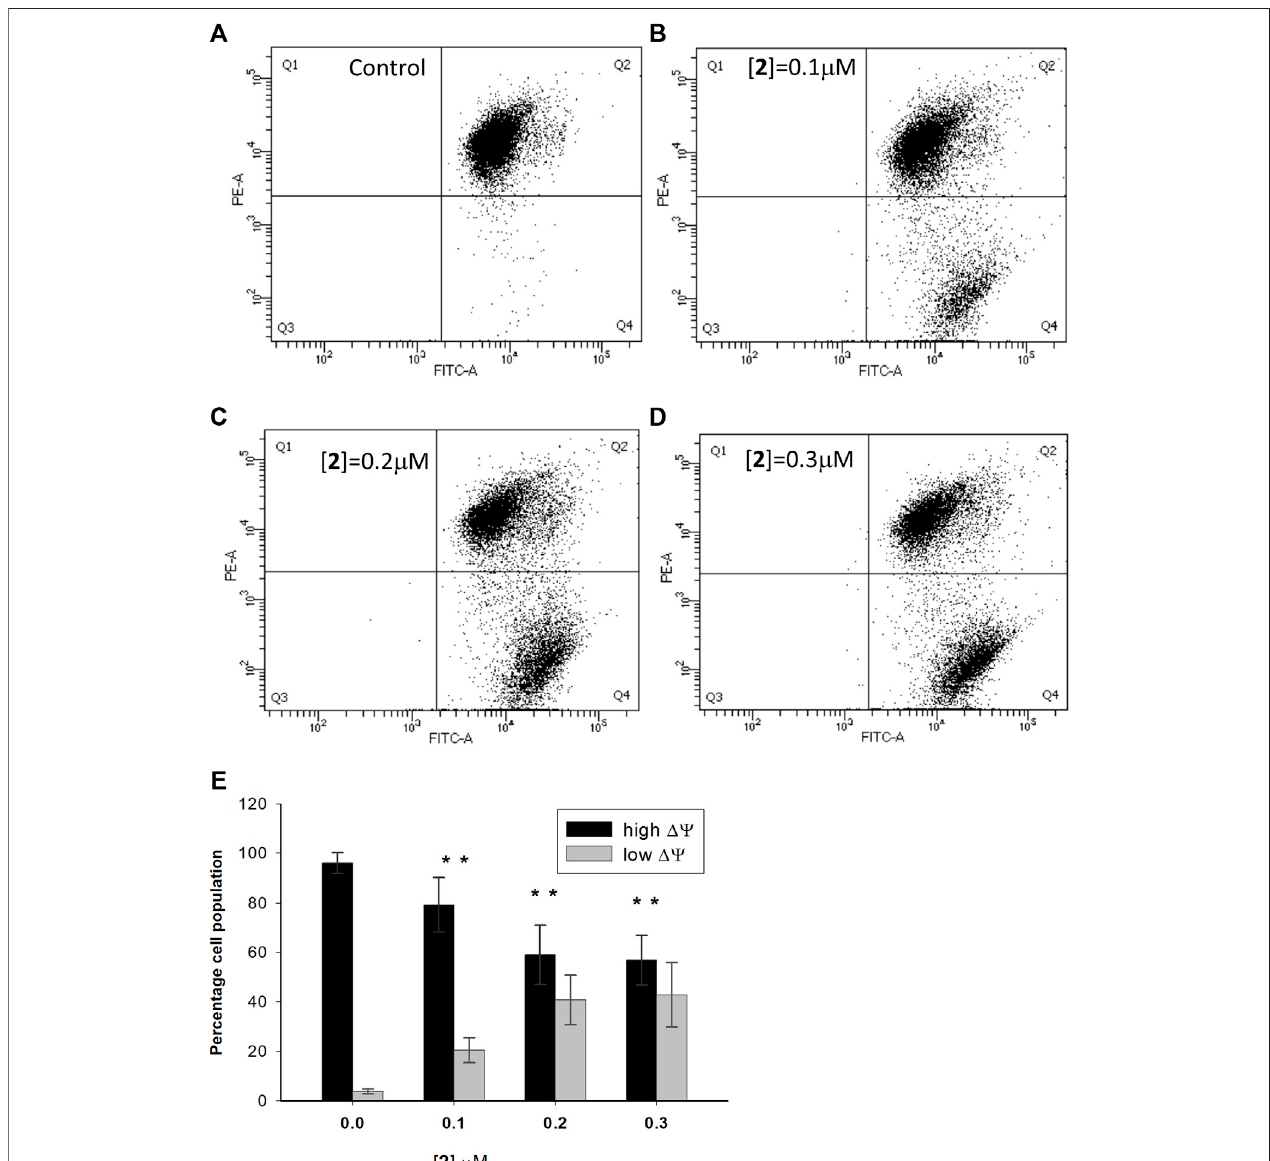
FIGURE 4 | Effect of compound 2 on the mitochondrial membrane potential in A2780 cells. A2780 cells were incubated for 48 h with compound 2 at indicated concentrations and analyzed by a fl ow cytometer after staining with the cationic fl uorescent probe JC-1. The dot plots show a representative experiment for untreated cells (control) (A) and cells treated with 2 at 0.1, 0.2, and 0.3 μ M concentrations ( B – D , respectively). The bar chart (E) represents the percentage of cell population with high (Q2) and low (Q4) values of mitochondrial transmembrane potential. Data are expressed as the mean ± SD from fi ve independent experiments. * p < 0.05, in comparison to the control